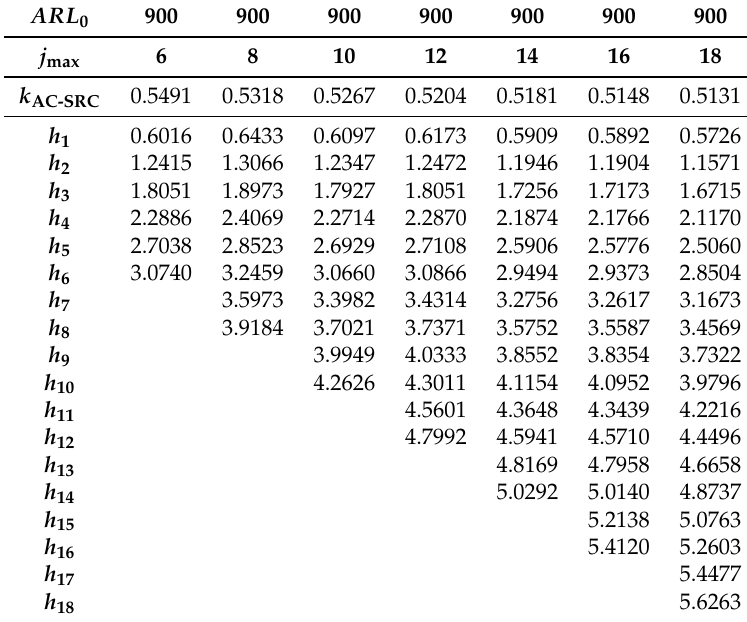
Table A10. AC-SRC for ARL 0 = 900.